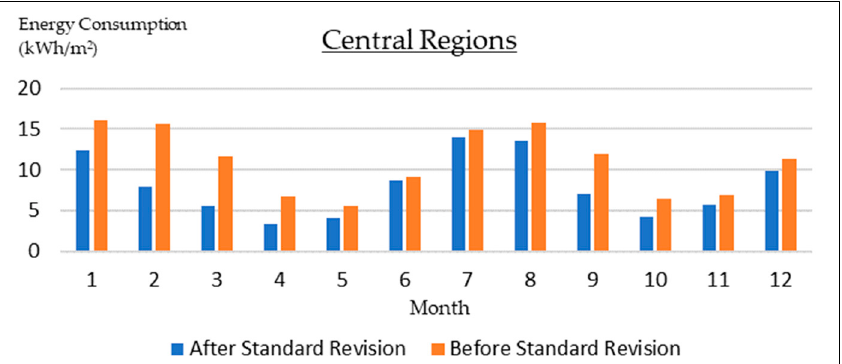
Figure 3. Bar chart of the monthly energy consumption of courthouse buildings in the central region based on the revision of the building insulation thickness standard.